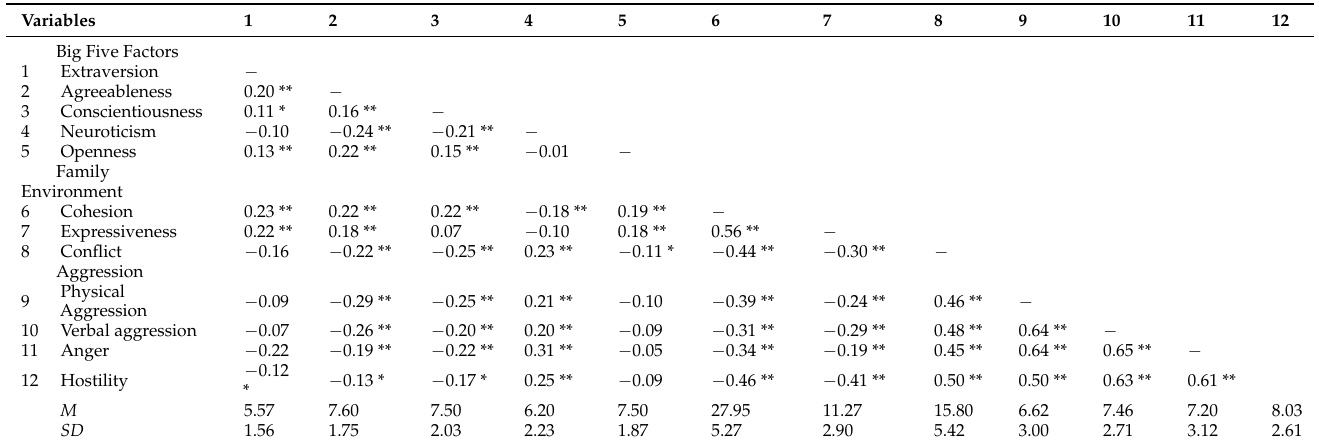
Table 2. Means, standard deviations, and bivariate correlations of study